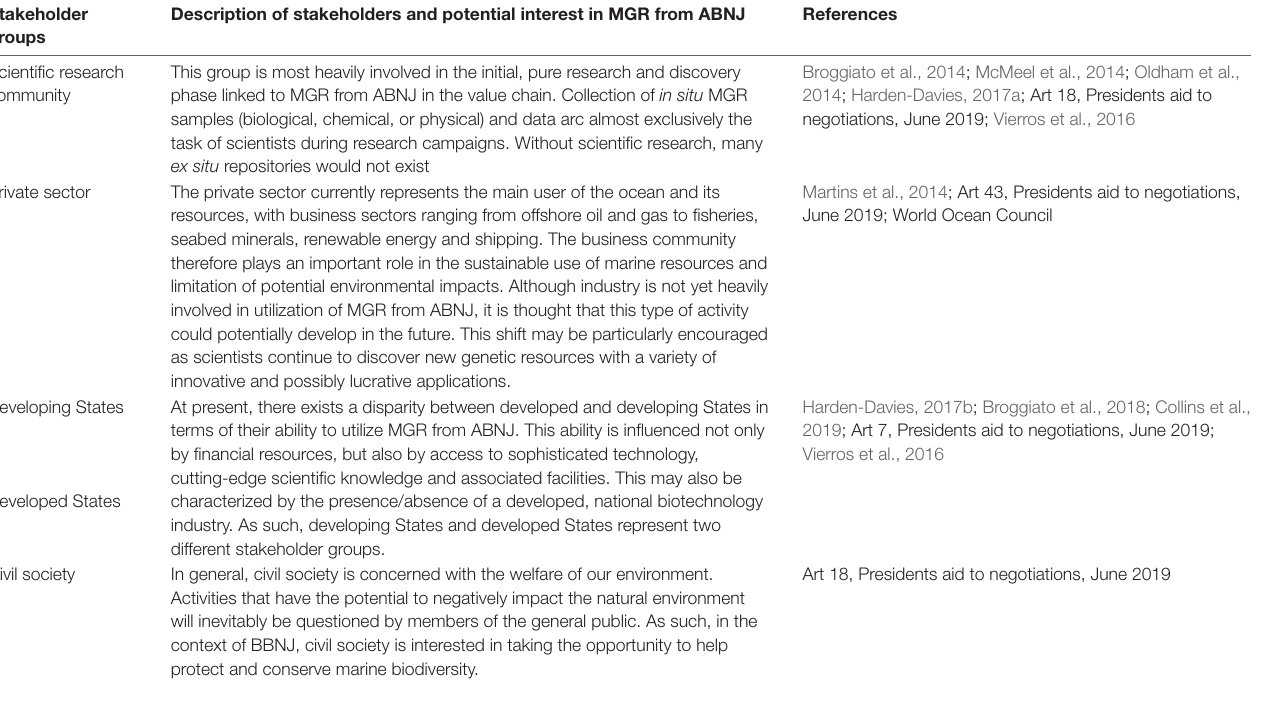
TABLE 1 | A list and description of the five main stakeholder groups linked to MGR from ABNJ. Stakeholder